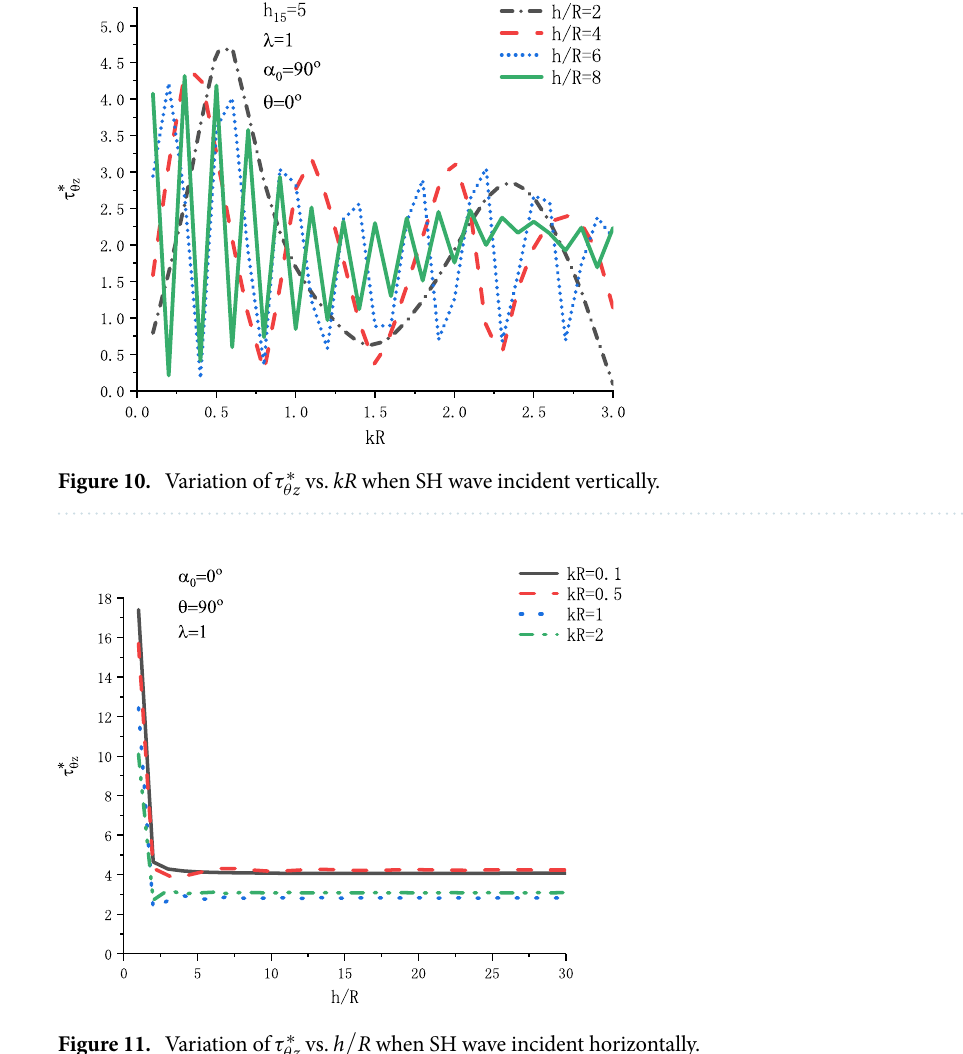
Figure 11. Variation of τ ∗ θ z vs. h